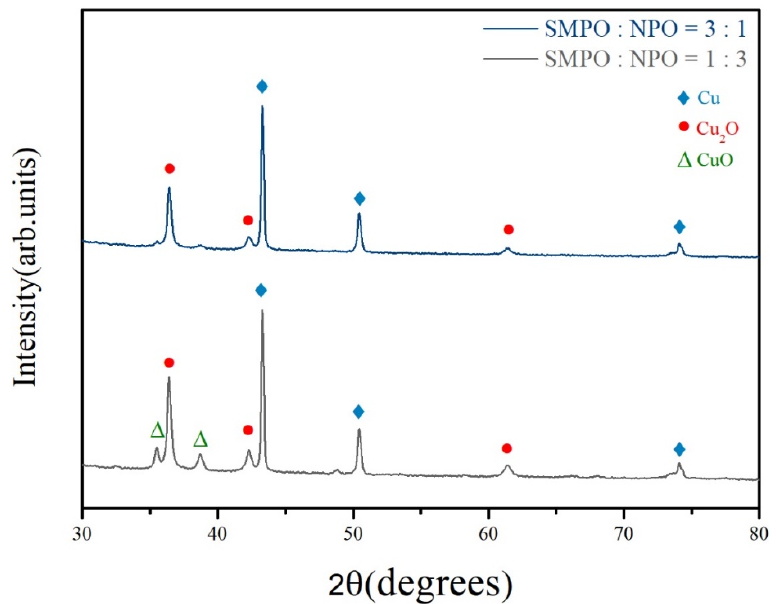
Figure 4. XRD patterns of hybrid pastes with various SMPO/NPO mixing ratios exposed to xenon flash pulses.